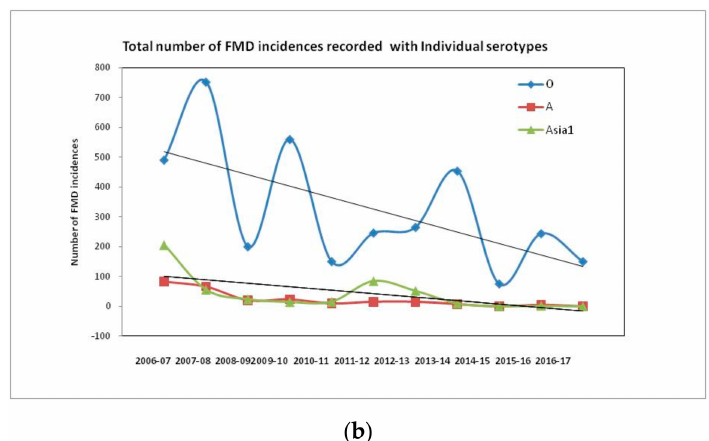
Figure 3. Total and serotype-wise temporal distribution of FMD outbreaks during the period from 2006–2017. The outbreak pattern was analyzed by simple linear regression with the coe ffi cient of determination and the best fit line along with slope (R 2 ) indicatinga gradual decrease in FMD outbreaks, which could be attributed to the e ff orts made in the FMD control program (FMDCP). ( a ) Total